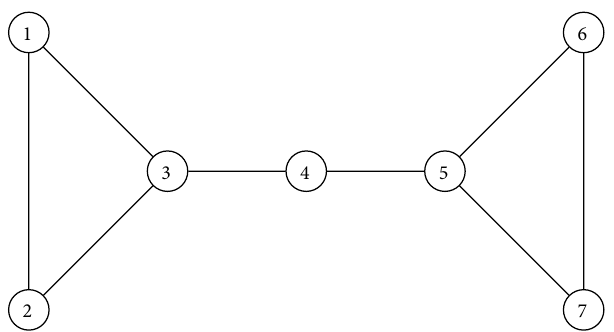
Figure 3: An example of how our greedy approach of Algorithm 1